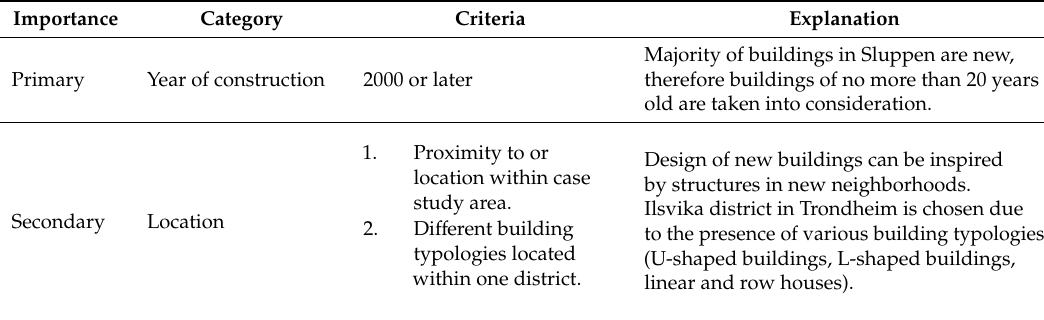
Table 7. Criteria for choosing buildings for reduction factor analysis.